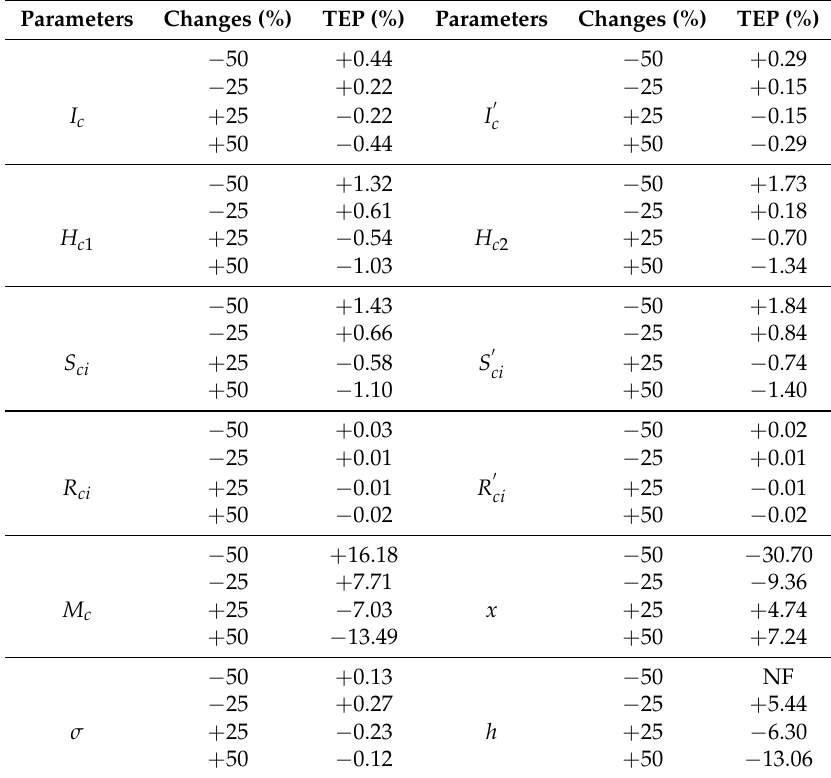
Table 9. Sensitivity analysis of the key